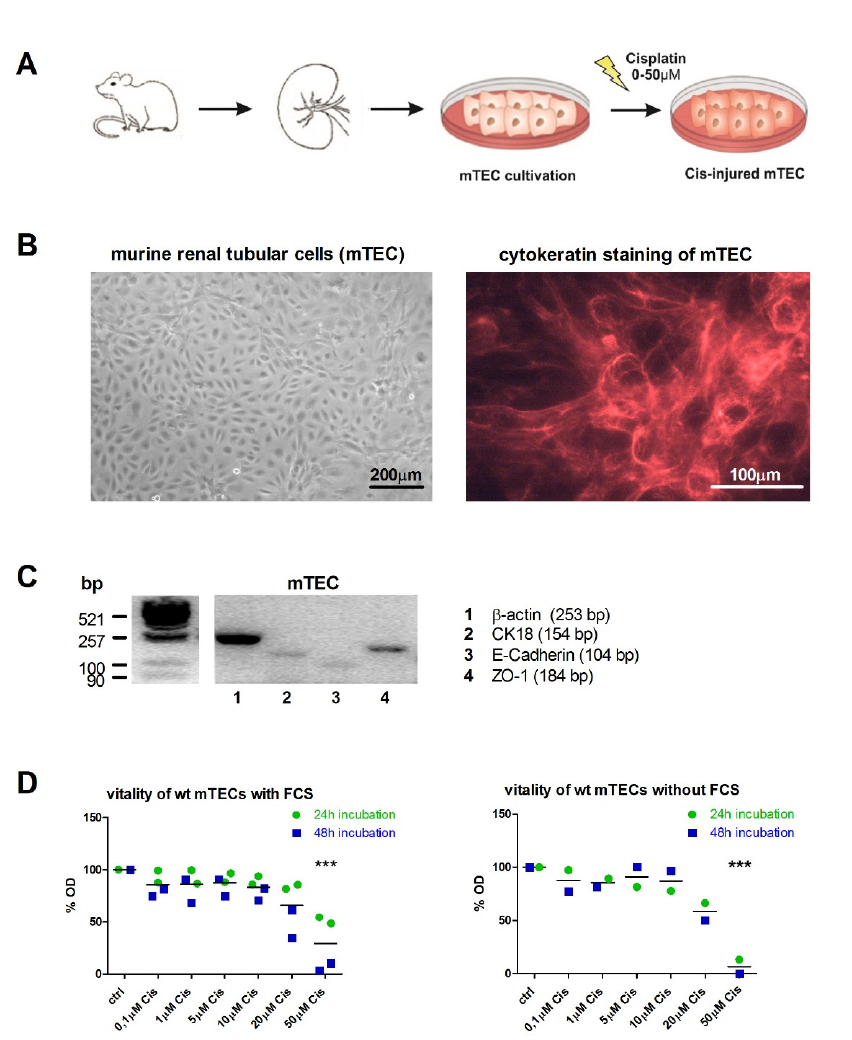
Figure 1. Primary murine tubular epithelial cells respond to Cisplatin-induced injury. ( A ) Schematic overview of experimental setup. ( B ) Cultured murine renal tubular epithelial cells (mTEC) in vitro displaying an epithelial morphology in culture (left) and stained positive for the epithelial cell marker cytokeratin 18 (right). ( C ) qPCR-analysis of epithelial cell markers cytokeratin 18 (CK18), E-Cadherin, and ZO-1 confirmed the epithelial origin of isolated primary mTEC. ( D ) Measurement of cell vitality via XTT assay using increasing Cisplatin concentrations: 0.1 μ M, 1 μ M, 5 μ M, 10 μ M, 20 μ M, 50 μ M, and untreated control (ctrl) for 24 h and 48 h, respectively. The untreated ctrl has been set on 100% of